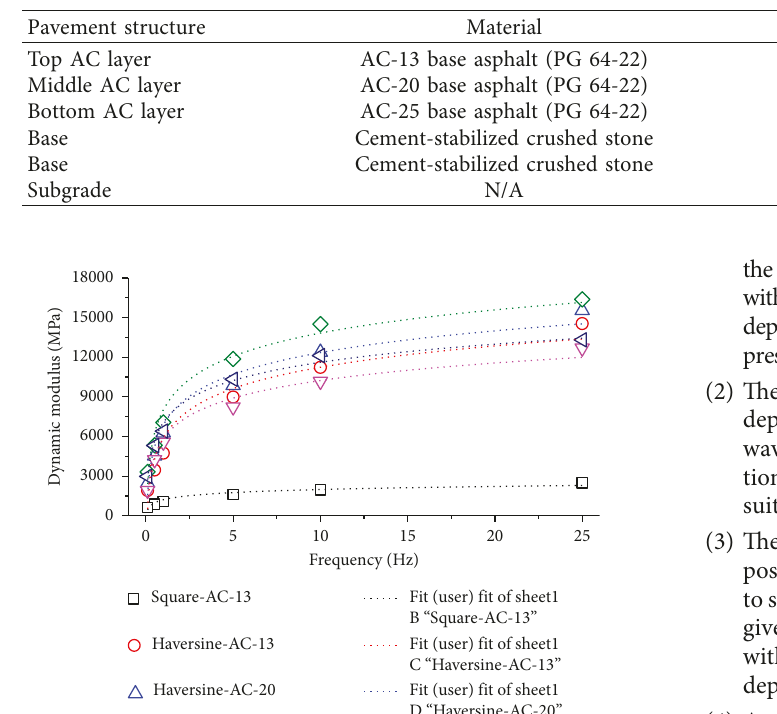
Table 2: Pavement structure and loading waveform.